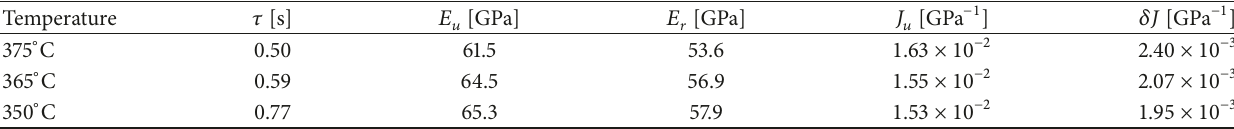
Table 5: Characteristic parameters of the Debye peaks in Figure 9(a), associated with a hypothetical mechanical relaxation. The values of 𝐸 𝑢 and 𝐸 𝑟 were fitted empirically. Only 𝜏 at 375 ∘ C was fitted empirically, while 𝜏 at 350 and 365 ∘ C was obtained with an Arrhenius equation for 1/𝜏 ((4)) with activation energy 0.60